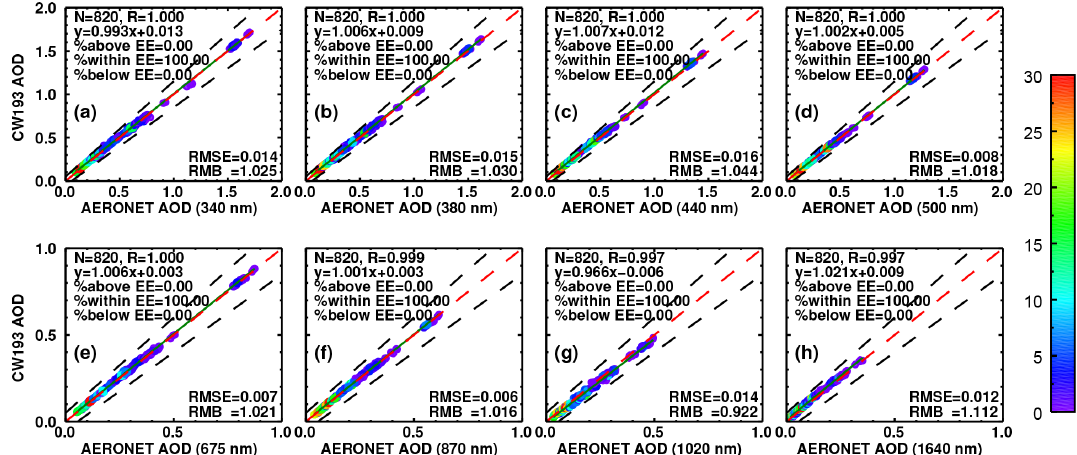
Figure 7. Validation of the CW193 AOD at each wavelength against the AERONET AOD. The one-to-one line, the linear regression line and the EE envelopes of ± (0.05 + 10%) are plotted as dashed red, solid green and dashed black lines,